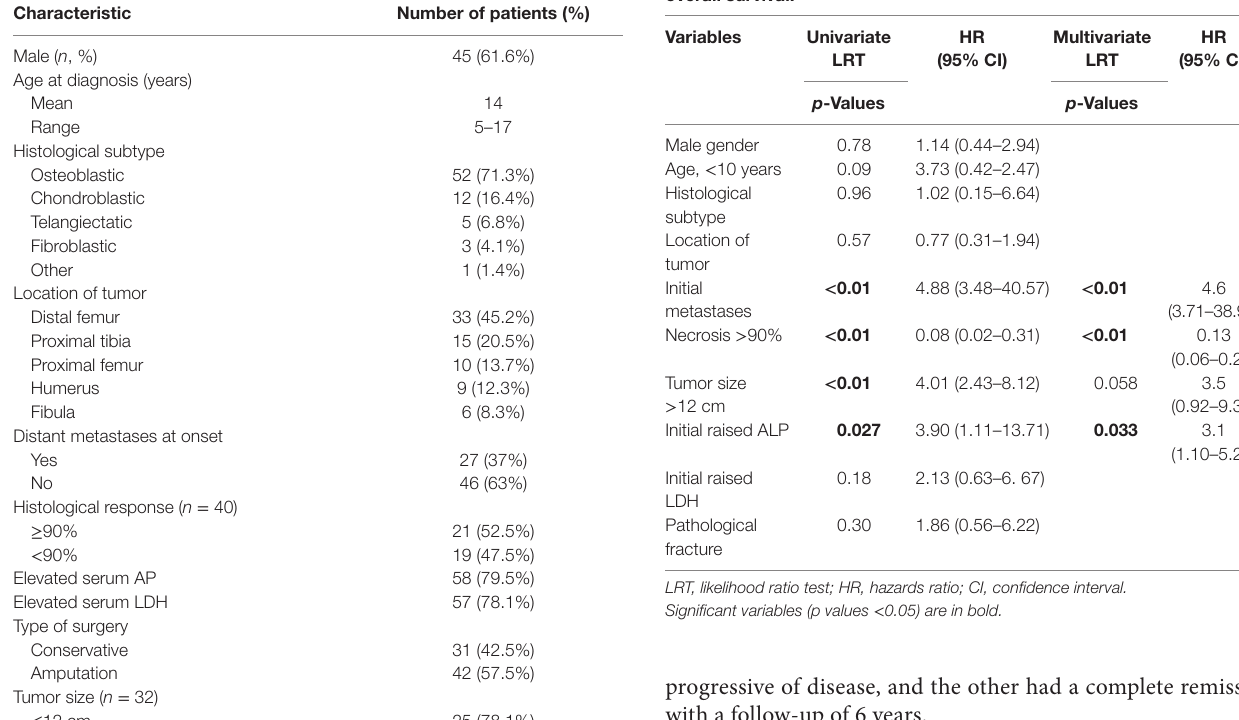
TaBle 1 | Demographic and clinical characteristics ( N = 73). TaBle 2 | summary of univariate cox proportional hazards model for overall